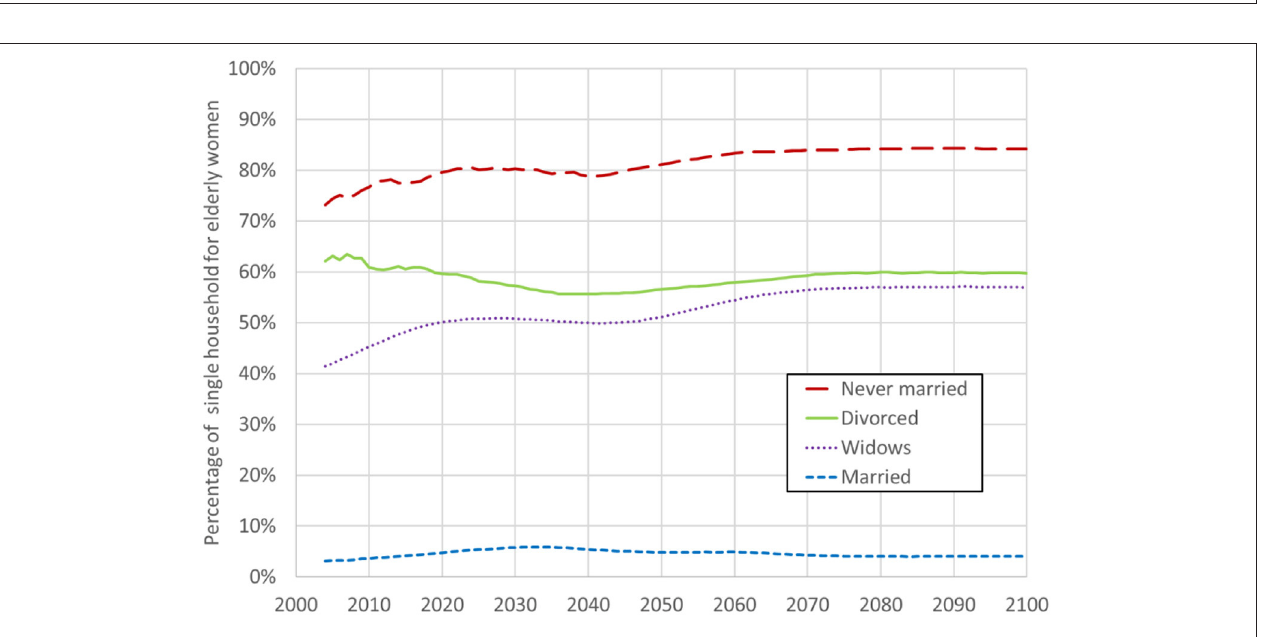
FIGURE 7 | Trends in percentages of single-person households for elderly women by marital status. Simulation